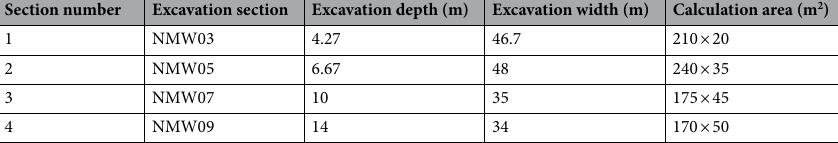
Table 3. Detailed dimensions of each section.